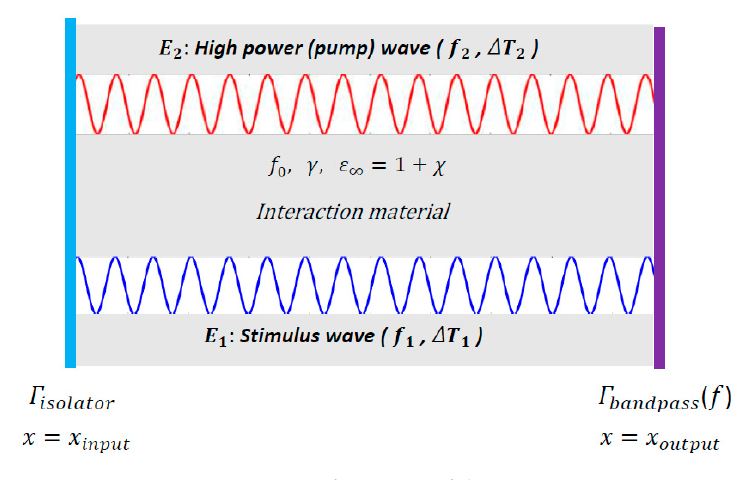
Figure 3. Configuration of the cavity.